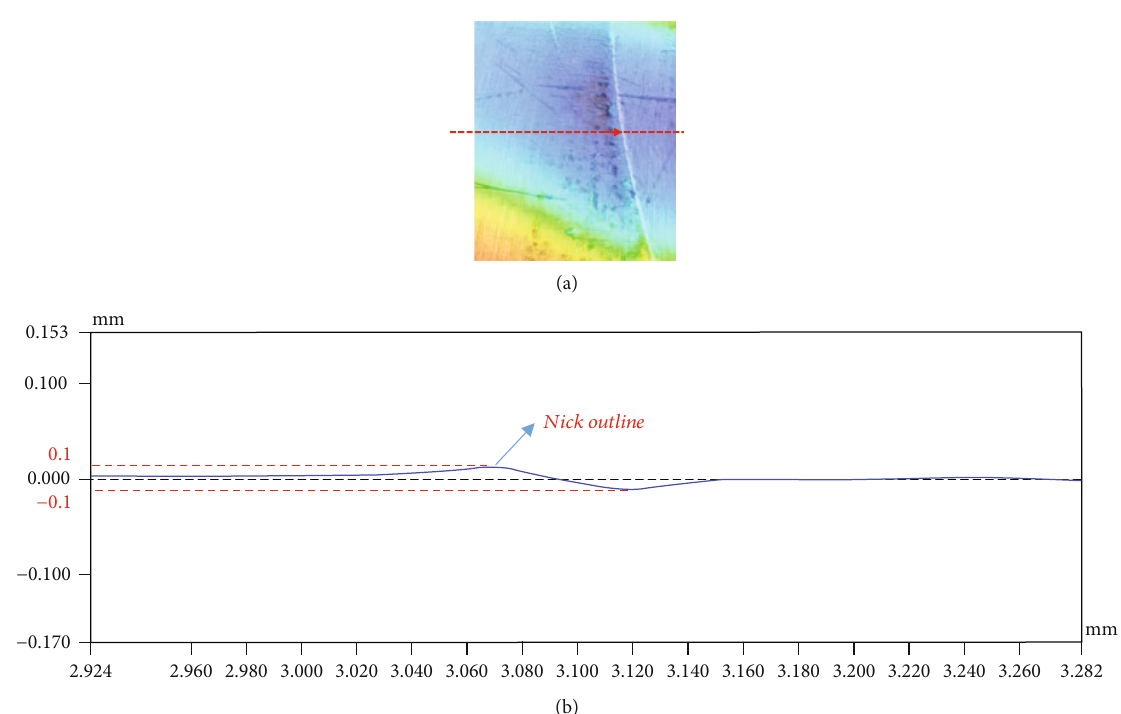
Figure 10: Experimental results based on the seal-form chimerism curve. (a) No chimerism at low pressures. (b) Sealing transition stage. (c) High-pressure chimerism stage.